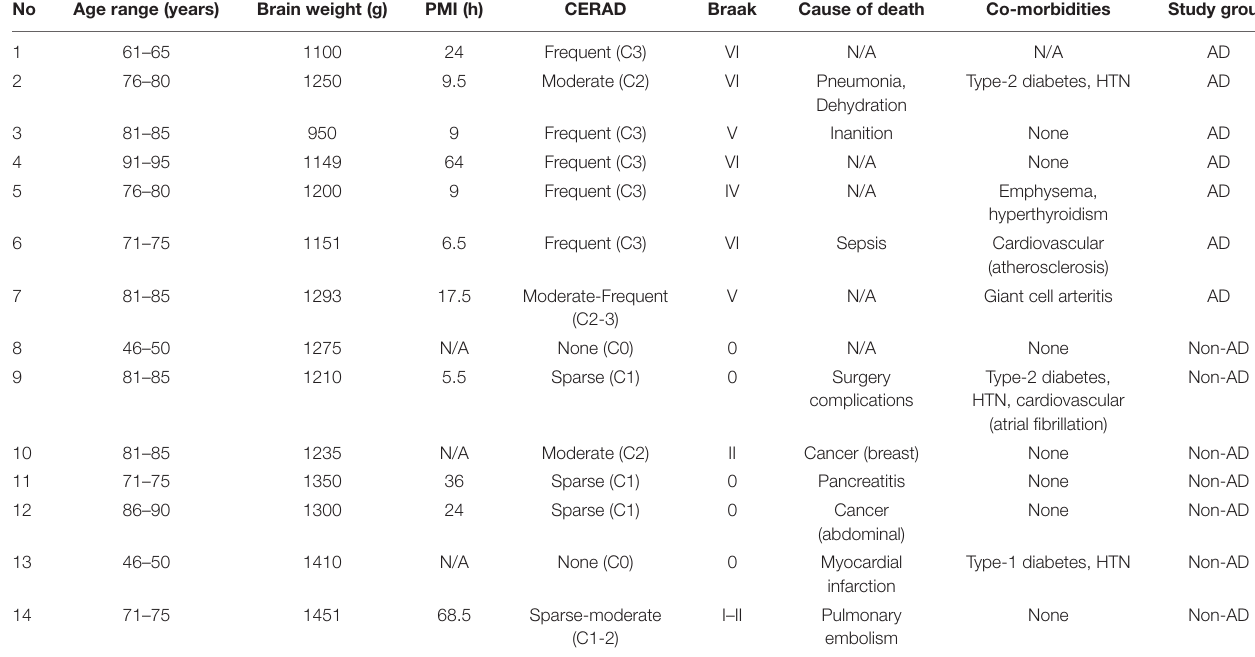
TABLE 1 | Subject